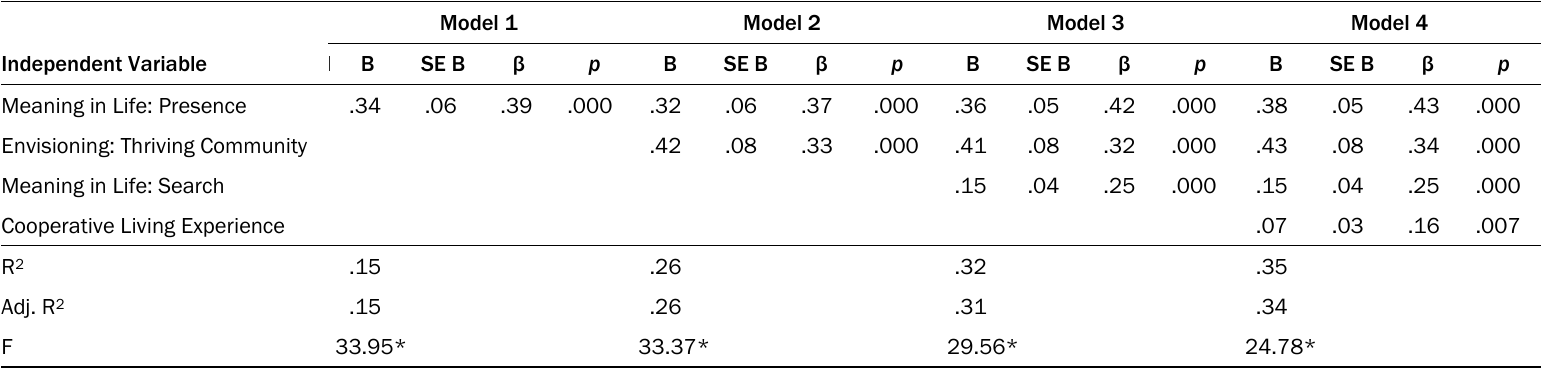
Table A4. Dependent Variable: Intrinsic Satisfaction From Participation Model 1 Model 2